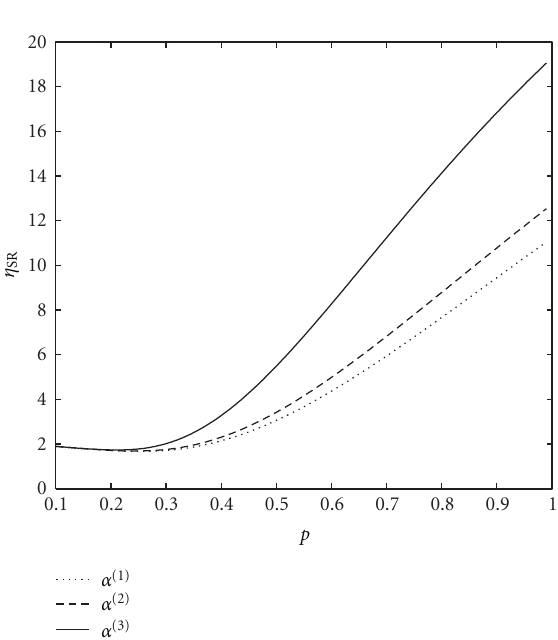
Figure 11: Mean loss of demand rate— p versus α ( n ) ( S = 90, s = 15, N = 25, λ = 8, β = 1 . 4, γ = 0 . 7, μ = 0 . 8 .